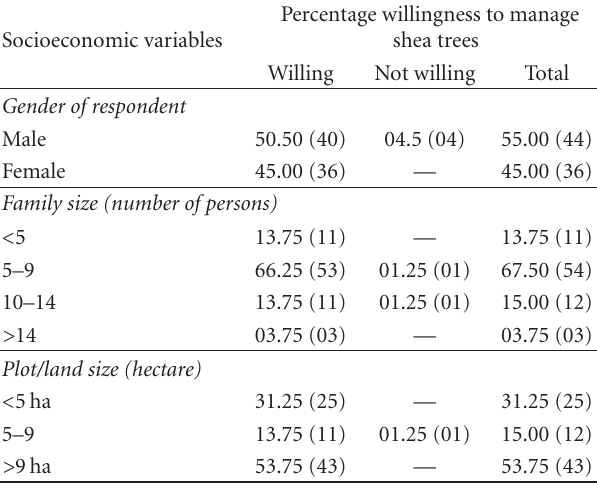
Figure 3: Who makes the decision to conserve shea trees within the faming households in Amuria district, eastern